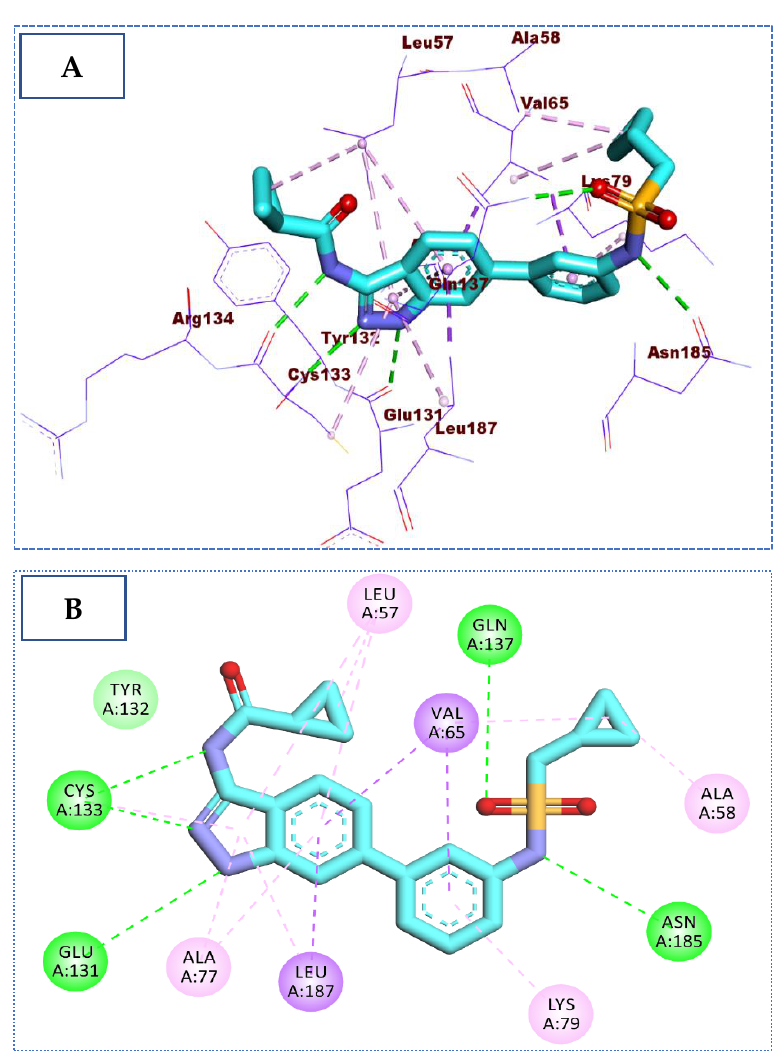
Figure 4. ( A ) The 3D and ( B ) 2D binding of co-crystallized ligand in the active site of BMP-2-inducible kinase (hydrogen bonds = green dashed lines, pi-pi interactions = purple dashed lines, and pi-alkyl interactions = light pink dashed lines).